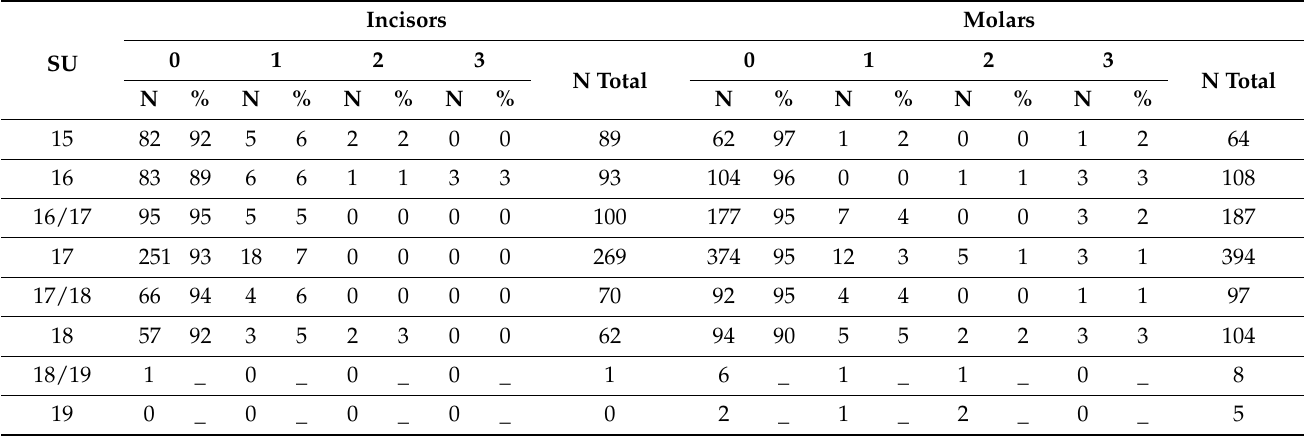
Table 2. Number (N) and percentage (%) of digested Arvicolinae teeth for each SU (Stratigraphic Unit), according to the intensity of the alteration defined by Andrews (1990): 0 = null; 1 = light; 2 = moderate; 3 =